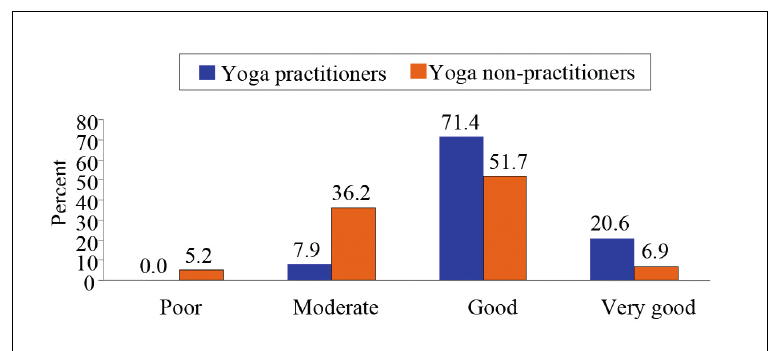
Note. x ² = 20, df = 3, p <